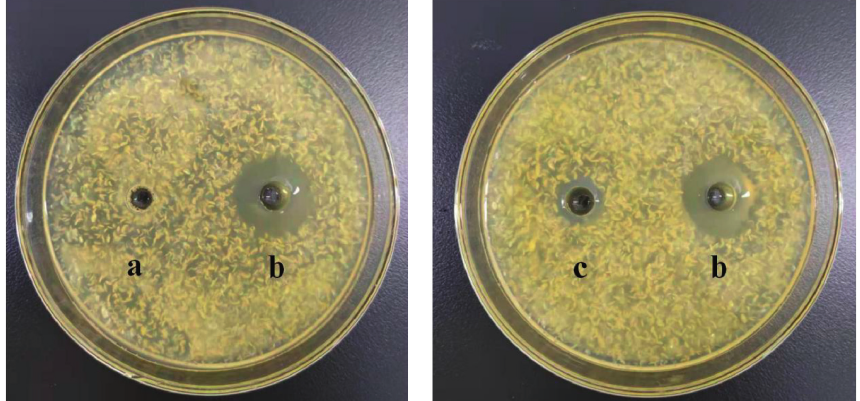
Figure 8: Antibacterial activity of TSP toward Escherichia coli bacterial strains: (a) dH